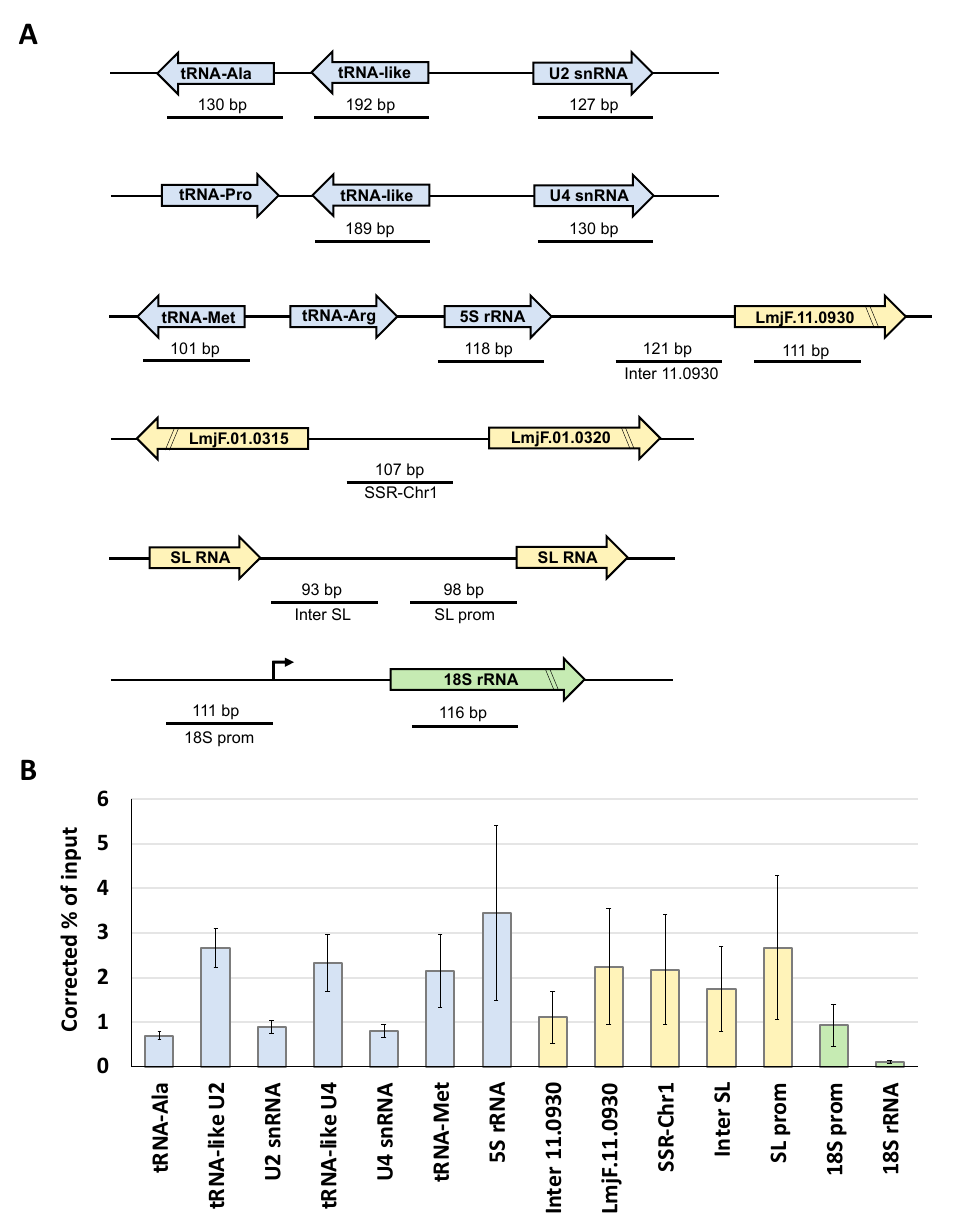
Figure 5. Chromatin immunoprecipitation (ChIP) analysis of LmBrf1. ( A ) Schematic representation of the genes and promoter regions examined. Genes transcribed by Pol III, Pol II, and Pol I are shown in blue, yellow, and green, respectively. Maps are not to scale. ( B ) Chromatin from a clonal cell line that expresses the recombinant protein LmBrf1-PTP was precipitated with a ChIP-grade anti-Prot A antibody. Precipitated DNA was analyzed by qPCR. The results from three independent ChIP experiments, each analyzed by two qPCR reactions, are shown. Results are presented as percentage of input, corrected by subtracting corresponding values from negative control precipitations performed with a nonspecific antiserum. Error bars indicate standard errors.